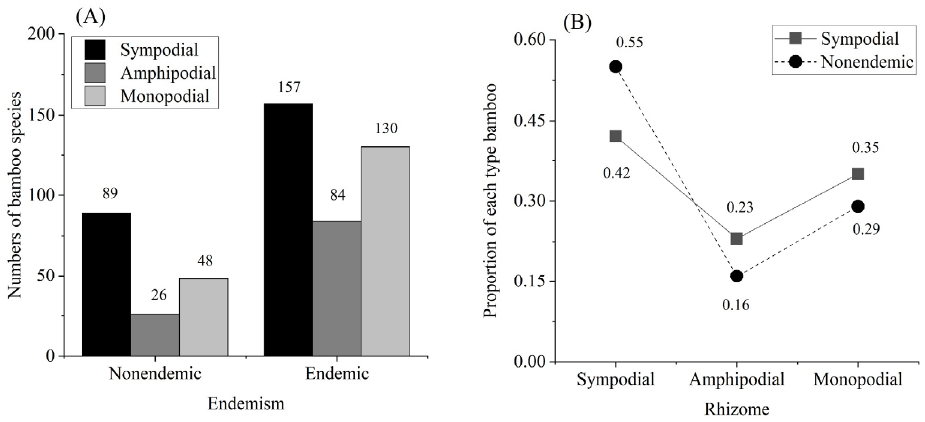
Figure 1. ( A ) Number of bamboo species; ( B ) Proportion of each type bamboo. Bamboos in China are mostly distributed south of 30 ◦ N latitude, in southwest and south China (Figure 2). The distribution centers of non-endemic sympodial bamboos are mainly located in the Hengduan Mountains, the alpine gorge region of western Sichuan, Yunnan-Guizhou Plateau Guangdong and Guangxi Hills. The distribution centers of non- endemic amphipodial bamboos are located in the Hengduan Mountains, the alpine gorge region of western Sichuan, Yunnan-Guizhou Plateau, Wuling Mountains, Daba Moun- tains, Nanling Mountains, Guangdong and Guangxi Hills, the Middle-lower Yangtze Plain, Wuyi Mountains, and Taiwan Island, dispersedly. The distribution centers of non-endemic monopodial bamboos are mainly located in Nanling Mountains, Guangdong and Guangxi Hills, and Wuyi Mountains (Figure 2a). The distribution centers of endemic sympodial bam- boos in China are mainly in the alpine gorge region of western Sichuan, Yunnan-Guizhou Plateau, Wuling Mountains, Guangdong and Guangxi Hills, and Nanling Mountains. The distribution centers of endemic amphipodial bamboos in China are mainly located in the alpine gorge region of western Sichuan, Wuling Mountains, Qingling and Daba Mountains, Nanling Mountains, Guangdong and Guangxi Hills, and Wuyi Mountains. The distribution centers of endemic monopodial bamboos are mainly located in the Hengduan Mountains, the alpine gorge region of western Sichuan, Yunnan-Guizhou Plateau, Nanling Mountains, Guangdong, and Guangxi Hills, and Wuyi Mountains (Figure 2b).